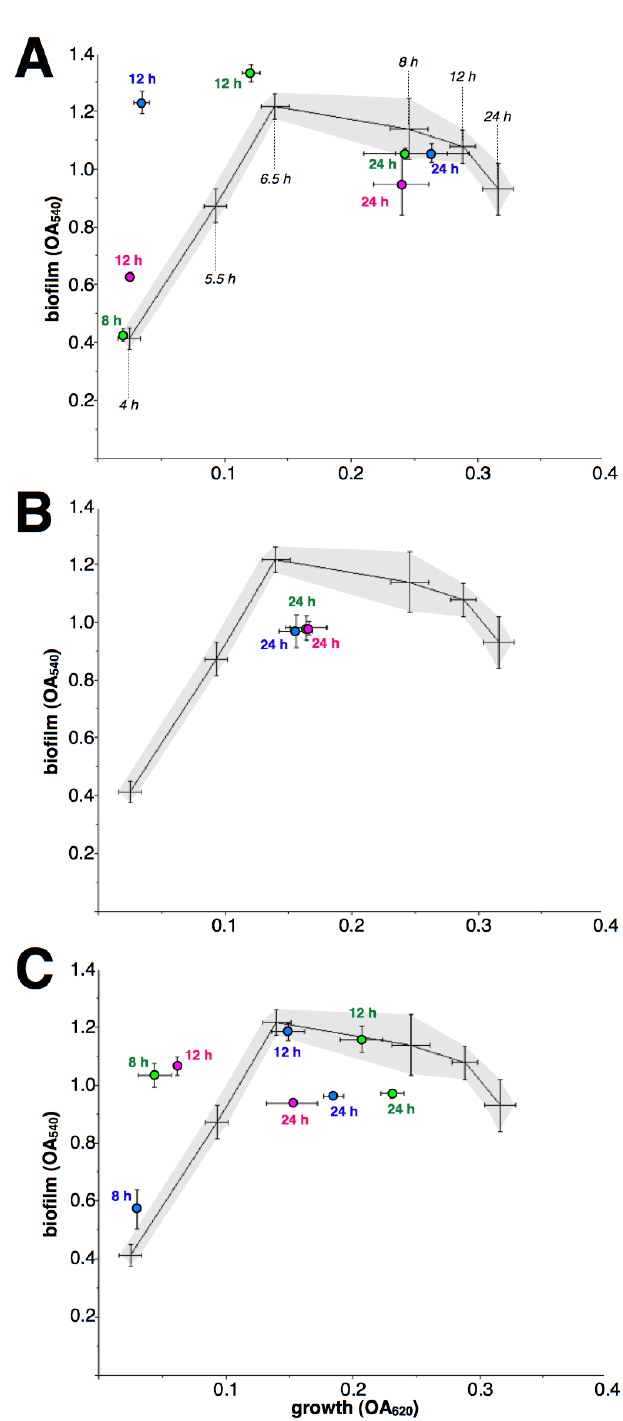
Figure 4. Effect of macrolides upon biofilm formation by S. aureus strain i2 (inducible MLS B ). Lines (means of four independent experiments) and dashed areas (defined by standard deviations of each point) show the relationship growth/biofilm formation (as OA at 620 and 540 nm, respectively) in the absence of antibiotics at 4, 5.5, 6.5, 8, 12 and 24 h (indicated with black italics only in the top figure). The effect of ERY ( A ), CLA ( B ) and AZI ( C ) at 8, 12 and 24 h is shown as circles (means with standard deviations of four independent experiments), green for 0.5 µg/mL, blue for 1 µg/mL and magenta for 2 µg/mL; close to each symbol, numbers indicate incubation time. Missing data was caused by non-detectable growth (ERY 2/8, ERY 1/8, CLA 8 and 12 h and AZI 2/8).